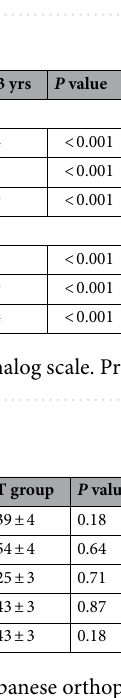
Figure 4. Frequency of complications. The frequency of asymptomatic ASD was significantly higher in the O group. There was no significant difference in symptomatic ASD between the O group and T group, and no significant difference in reoperation cases between the O group and T group. Abbreviations: T group, patients who underwent single-level transforaminal lumbar interbody fusion; O group, patients who underwent single- level oblique lateral interbody fusion; ASD, adjacent segment disorder.